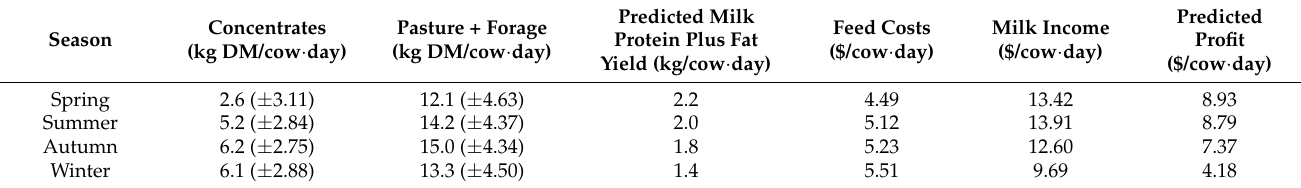
Table 8. Predicted profit maximising combination of inputs (concentrates and pasture + forage ± standard error) for milk protein plus fat yield, for each season, based on modelled